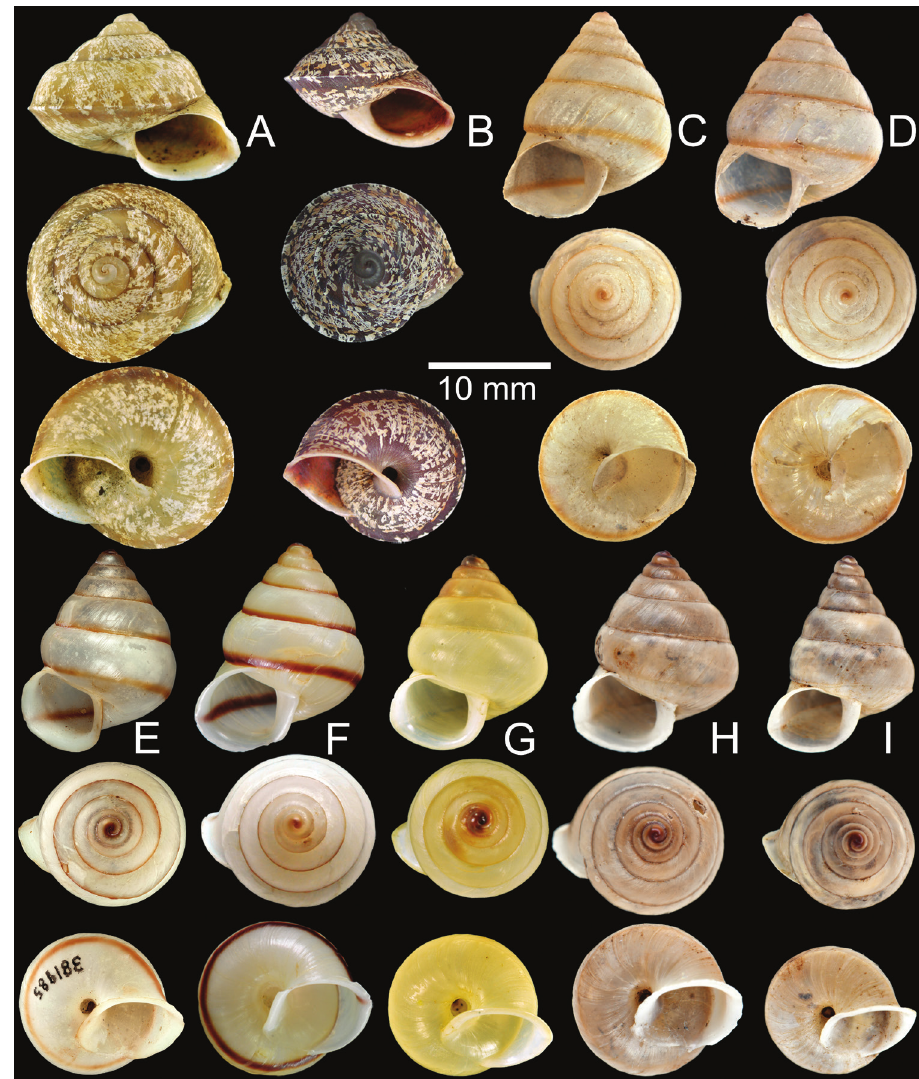
Figure 3. A, B Ganesella carinella A shell from Lopburi CUMZ 4282 and B shell from Tam Brichinda, Chiangmai CUMZ 4165 C–I Ganesella rhombostoma C lectotype NHMUK 20130215/1 D paralecto- type NHMUK 20130215/2-3 E shell of “ harryleei Thach, 2017” from Cambodia FMNH 381985 F shell from Klonghad, Srakeo CUMZ 5132 G shell from Chachoengsao CUMZ 5130 H shell from Sirisophon, Cambodia CUMZ 5131 and I shell from Srakaeo CUMZ